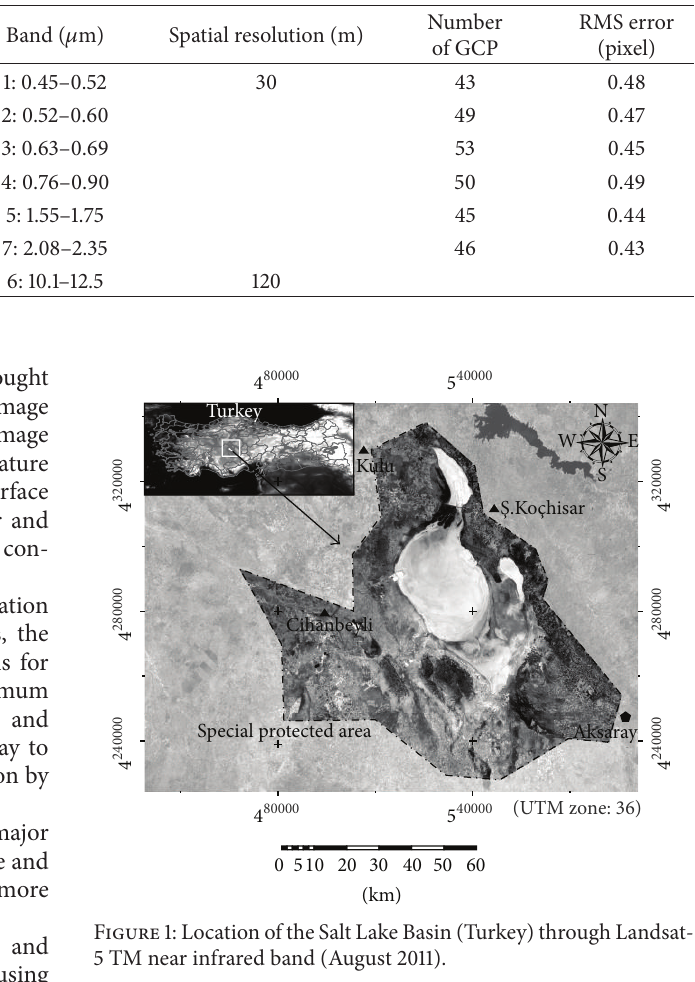
Table 1: Specifications of Landsat data used in the study.